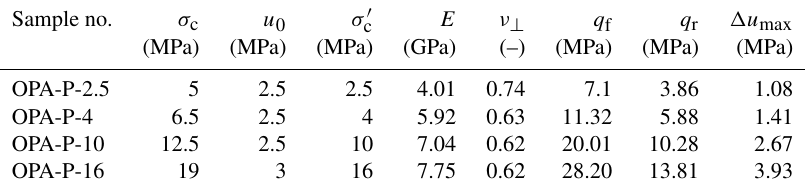
Table 2. Overview of experimental parameters ( σ c : total confining stress; u 0 : initial pore water pressure before shearing; σ (cid:48) c : effective confining stress before shearing) and elastic ( E : Young’s modulus; ν ⊥ : Poisson’s ratio), hydro-mechanical, and strength parameters ( q f : differential stress at failure; q r : residual differential stress; (cid:49)u max : maximum change in pore pressure during shearing phase).